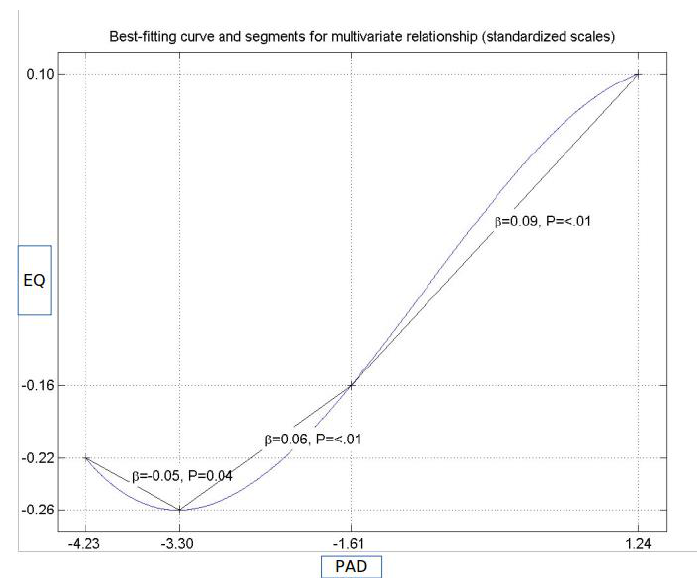
Figure 2. The non-linear relationship between procedural accuracy—doctors (PAD) and patients’ perception of the experienced quality of health services (EQ).